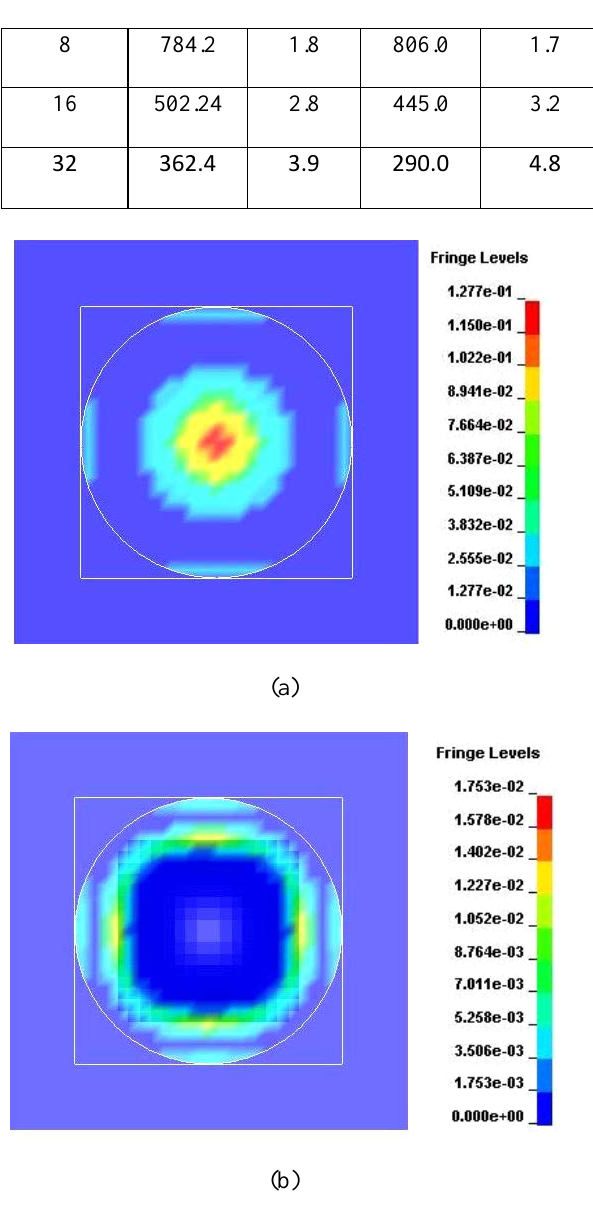
Fig. 14. Plastic strain plot for (a) baseline design (b) opti- mized design Table 6. Results for Baseline and Optimized Designs